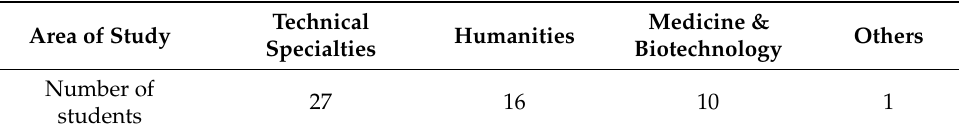
Table 4. The Bolashak international scholarship holders by area of